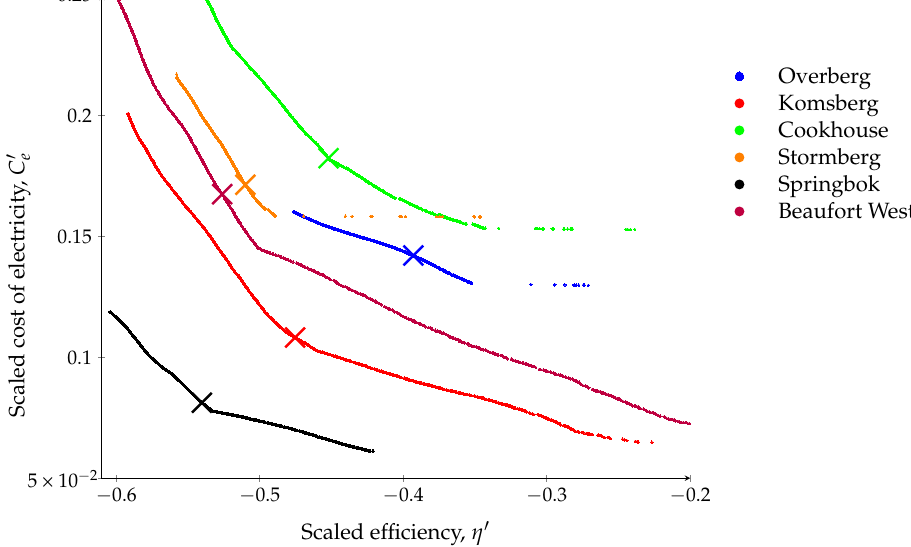
Table 10. NSGA-II operating parameters. Optimization Parameters Population size: 500